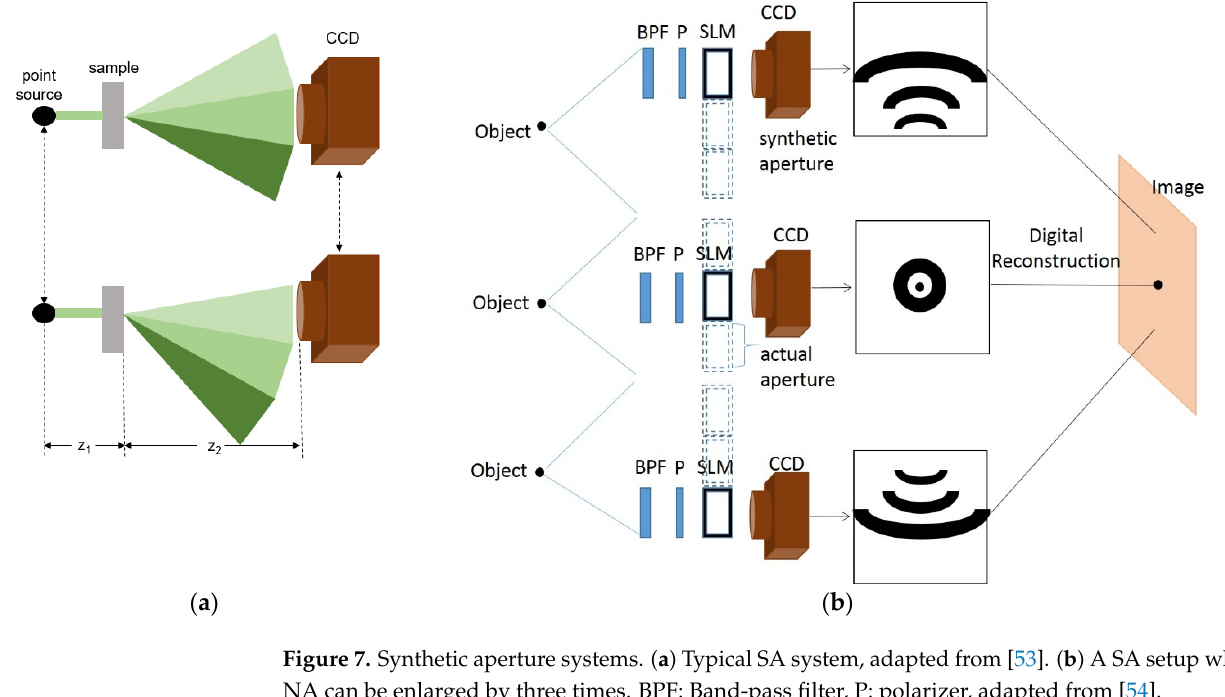
Figure 7. Synthetic aperture systems. ( a ) Typical SA system, adapted from [53]. ( b ) A SA setup where NA can be enlarged by three times. BPF: Band-pass filter, P: polarizer, adapted from [54].